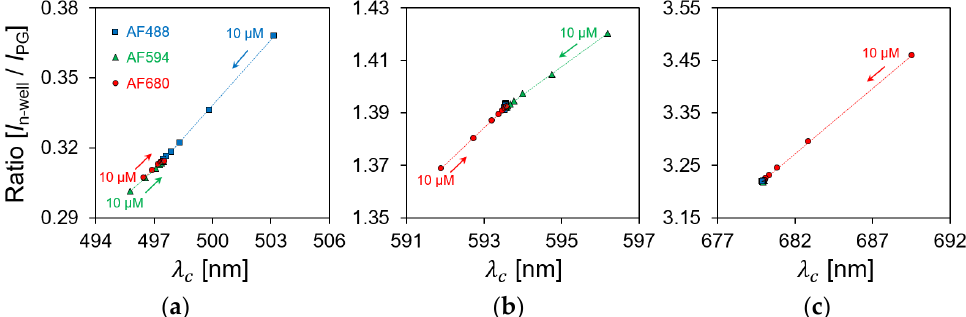
Figure 13. Relationship between centroid wavelength and current ratio depending on fluorescent reagent concentration. ( a ) LED light source of 490 nm; ( b ) LED light source of 590 nm; ( c ) LED light source of 680 nm.